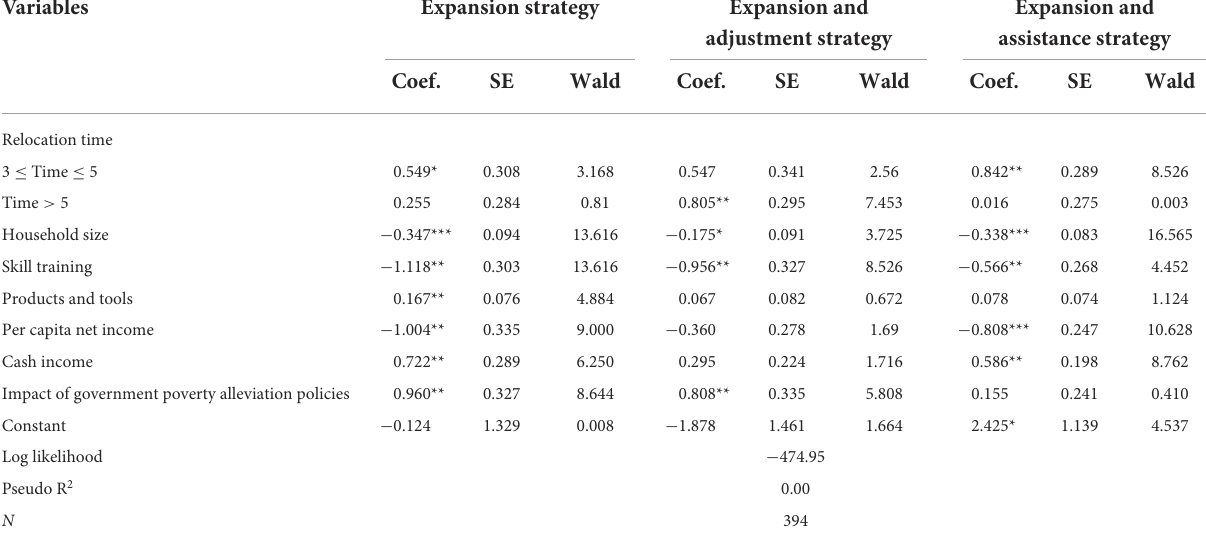
TABLE 5 The impact of relocation time on the choice of adaptation strategy.